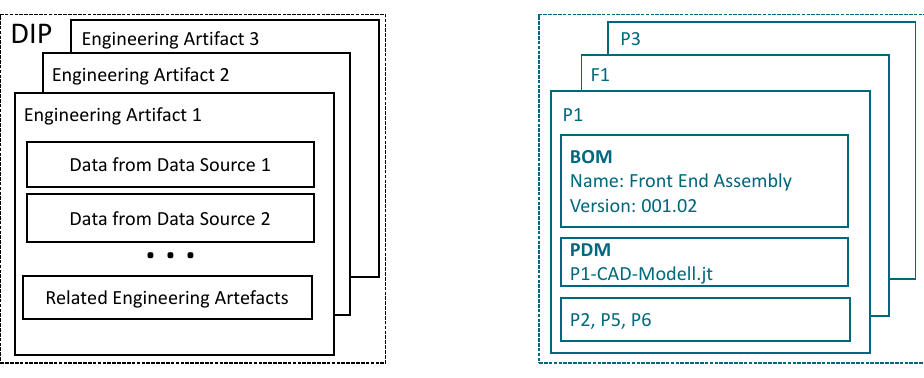
Figure 1. Left: Generic schema of the DIP, right: DIP of the case